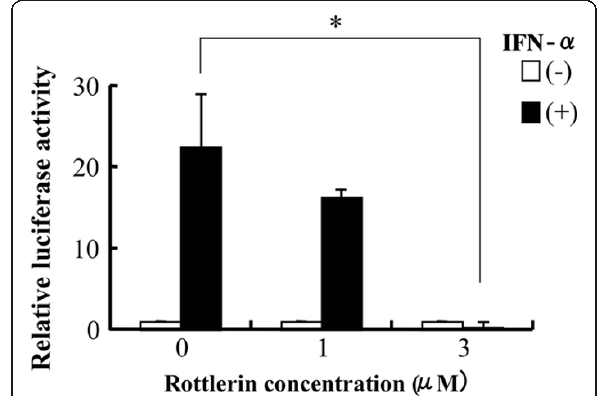
Figure 3 PKC- δ inhibitor rottlerin abrogates IFN- a -induced activity of TRAIL promoter in Daudi cells . Daudi cells were transfected with a TRAIL-Luc reporter, followed by incubation with medium alone for 24 h. The cells were pretreated with rottlerin for 1 h, stimulated with 1,000 U/ml IFN- a for 24 h, and then assayed for luciferase activity. Reporter activity was normalized relative to internal control Renilla luciferase values. Normalized data from experimental group are expressed as relative luciferase activity compared with those seen in control group. Each point represents mean ± SD from three independent experiments. *Significantly different ( p < 0.05) from control without